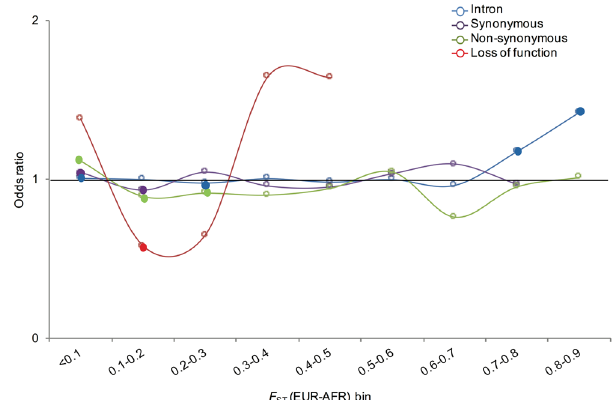
Figure 3. Relative proportion of SRE SNPs as a function of level of population differentiation ( F ST ). X-axis is F ST bin from the AFR-EUR comparison. Y-axis represents the odds ratio (OR) of SRE SNPs to non-SRE SNPs in each SNP class. The non-SRE SNPs served as control in this comparison within each F ST bin. The solid circle indicates statistically significant comparisons (P < 0.05). See Supplementary Figure 4 for the ASN-EUR comparison and the AFR-ASN